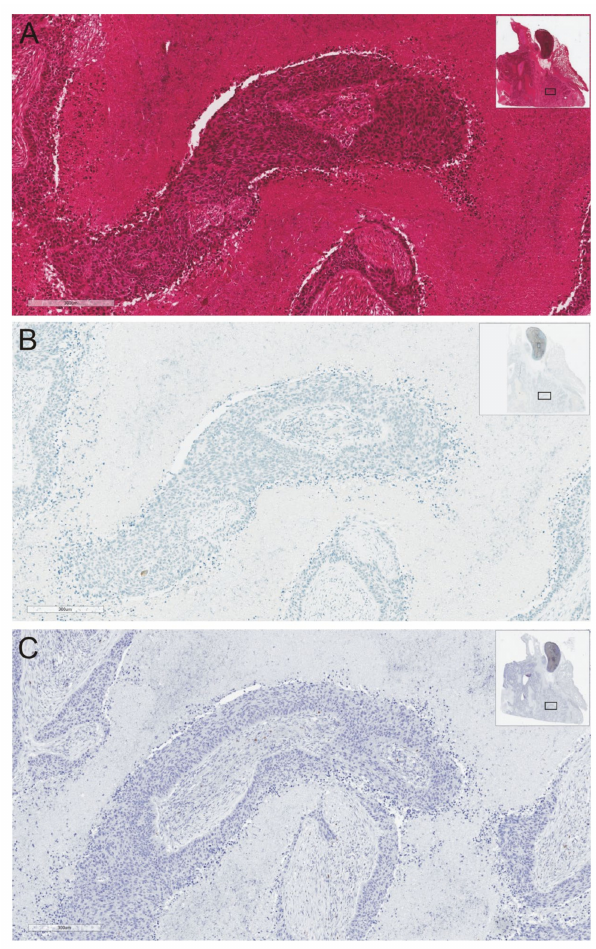
Figure 3. A case illustration of lung adenocarcinoma tissue without CD8+ lymphocyte infiltration and lack of PD-L1 expression on the tumor cells: ( A ). hematoxylin/eosine staining; ( B ). PD-L1 expression; ( C ). CD8 expression. Immunohistochemical staining was performed on authors’ own